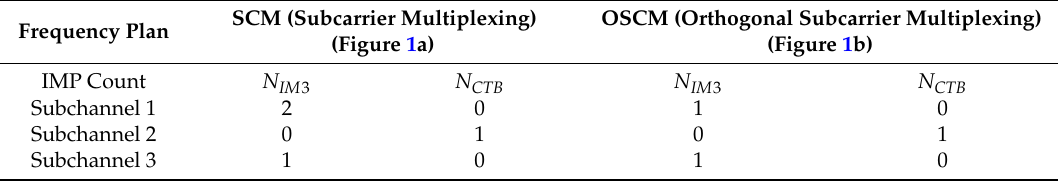
Table 1. IMP (intermodulation products) count for each subchannel in the photocurrent. SCM (Subcarrier Frequency Plan